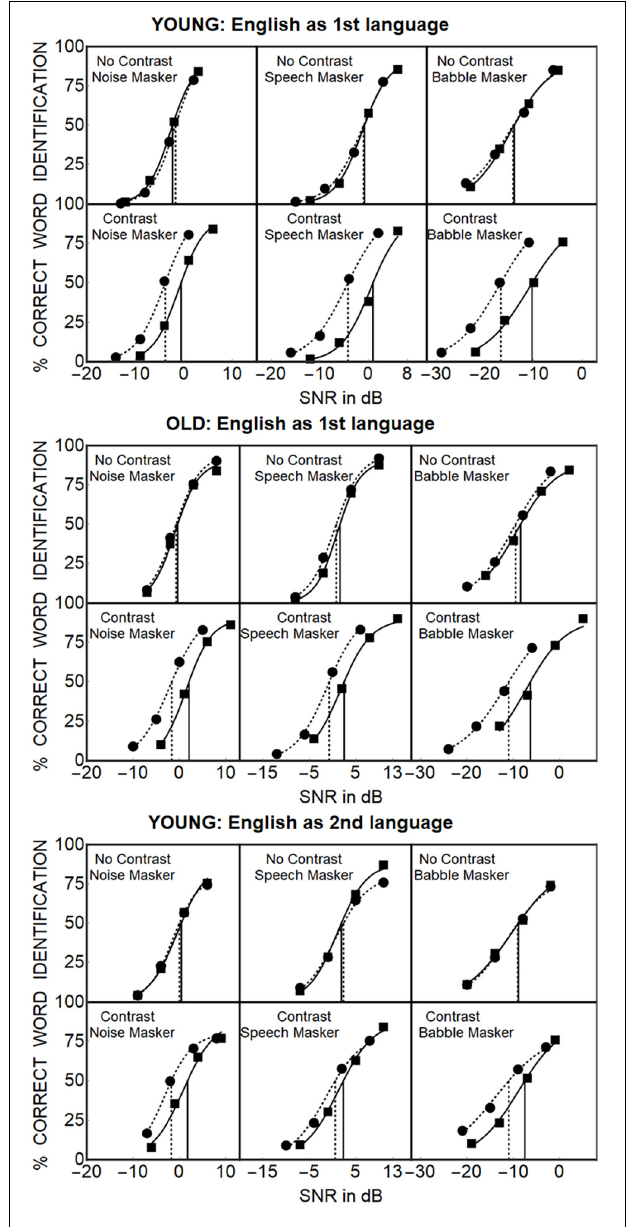
FIGURE 2 | Top. Young-EFL participants from Avivi-Reich et al. (2020). Center. Old-EFL participants, this experiment. Bottom. Young-ESL participants, this experiment. The percentage of words correctly identified is plotted as a function of SNR for each combination of the three maskers (Noise, Speech, and Babble) with the four target-masker combinations (TcMc, TdMd, TcMd, TdMc) for the three different groups of participants. The data for the No Contrast Conditions (TcMc and TdMd) are shown separately from the data when there is a timbre contrast between target and masker (TcMd and TdMc). Circles represent the average data for the Conditions where the target was compact (Tc), squares represent the data for diffuse targets (Td). Solid lines show the psychometric functions fit to that data when the target was diffuse (Td); dotted lines show the psychometric functions fit to the data when the target was compact (Tc). The SNRs corresponding to 50% correct identification when the target is compact are indicated by the dotted vertical lines. The solid vertical lines indicate the corresponding SNRs when the target is